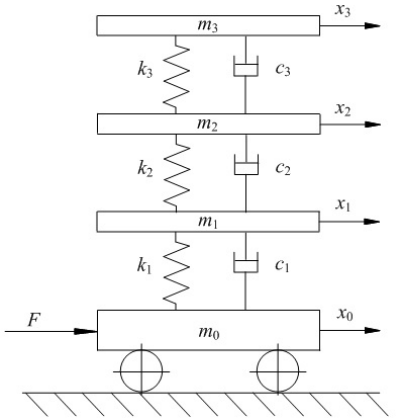
Figure 4. Mathematic dynamical model of the frame structure.